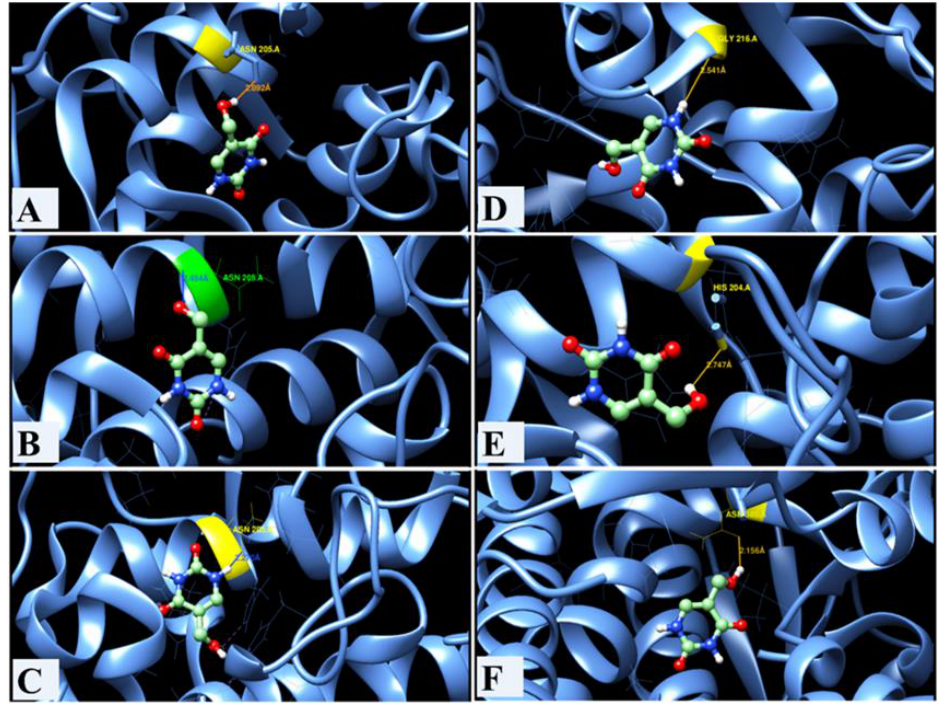
Figure 10. Ligand 5-HMU: embedded in the active sites of ( A ) 4P6T, ( B ) 4P6S, ( C ) 6QXD, ( D ) 6EI4, ( E ) 5OAE, and ( F ) 5M67 proteins. Table 5. Hydrogen bonding and molecular docking score of 5-HMU with protein